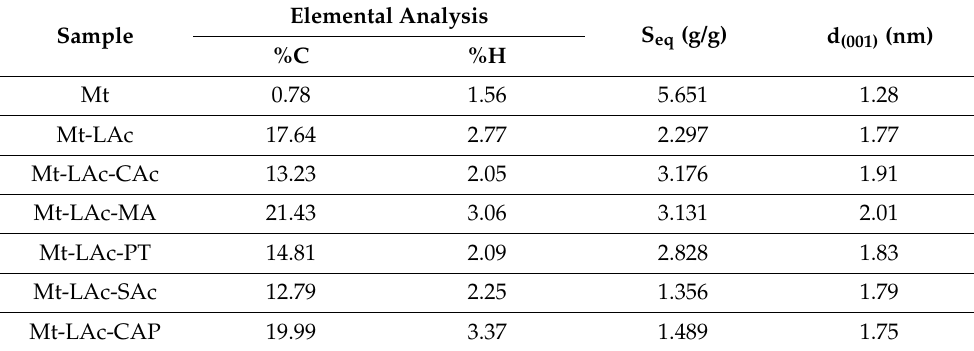
Table 1. Elemental analysis, interlayer distance d (001) , and swelling capacity (S eq ) for organophilic Mt.